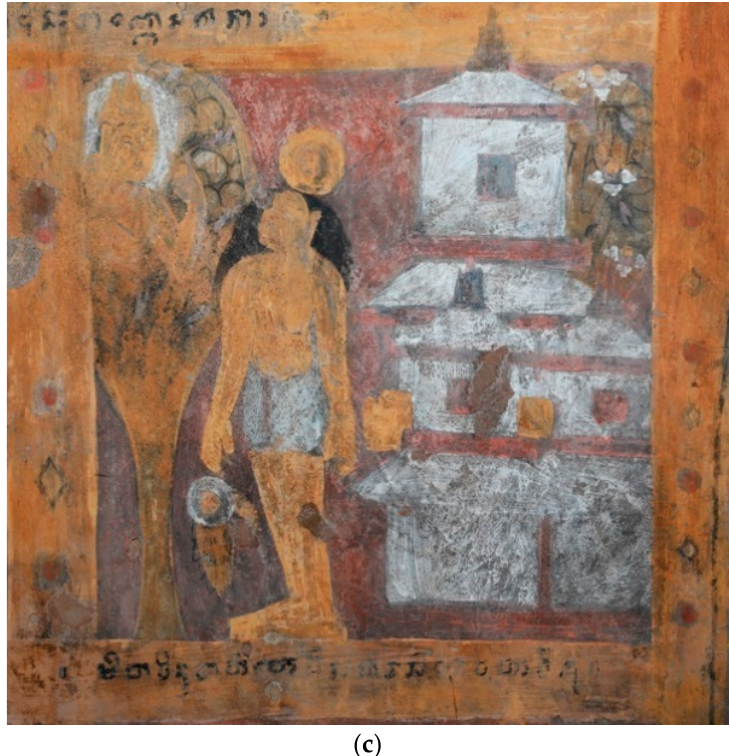
Figure 41. ( a ) Pagan, Ananda, 11th century. Mittavinda. ( b ) Pagan, Ananda, 11th century Mittavinda. ( c ) Pagan, Myinkba Kubyaugyi 1112 AD Mittavinda.